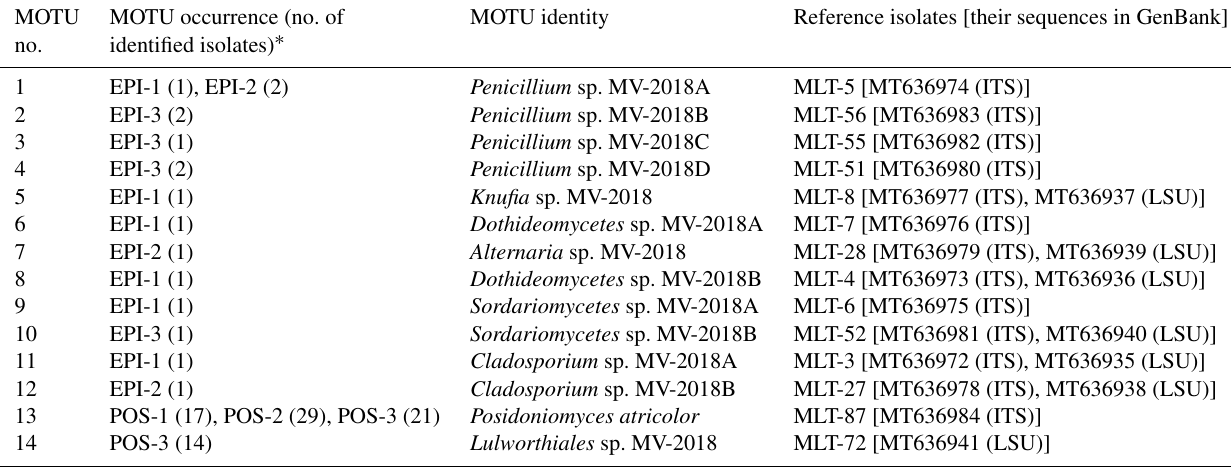
Table 3. Taxonomic affinities of the molecular operational taxonomic units representing mycobionts isolated in this study. Taxonomic affini- ties (identity) of the delimited molecular operational taxonomic units (MOTUs) are based on comparing representative ITS and/or LSU nrDNA sequences with those available in a public database (i.e., GenBank at NCBI) as described in Sect. 2. MOTU MOTU occurrence (no. of MOTU identity Reference isolates [their sequences in GenBank]